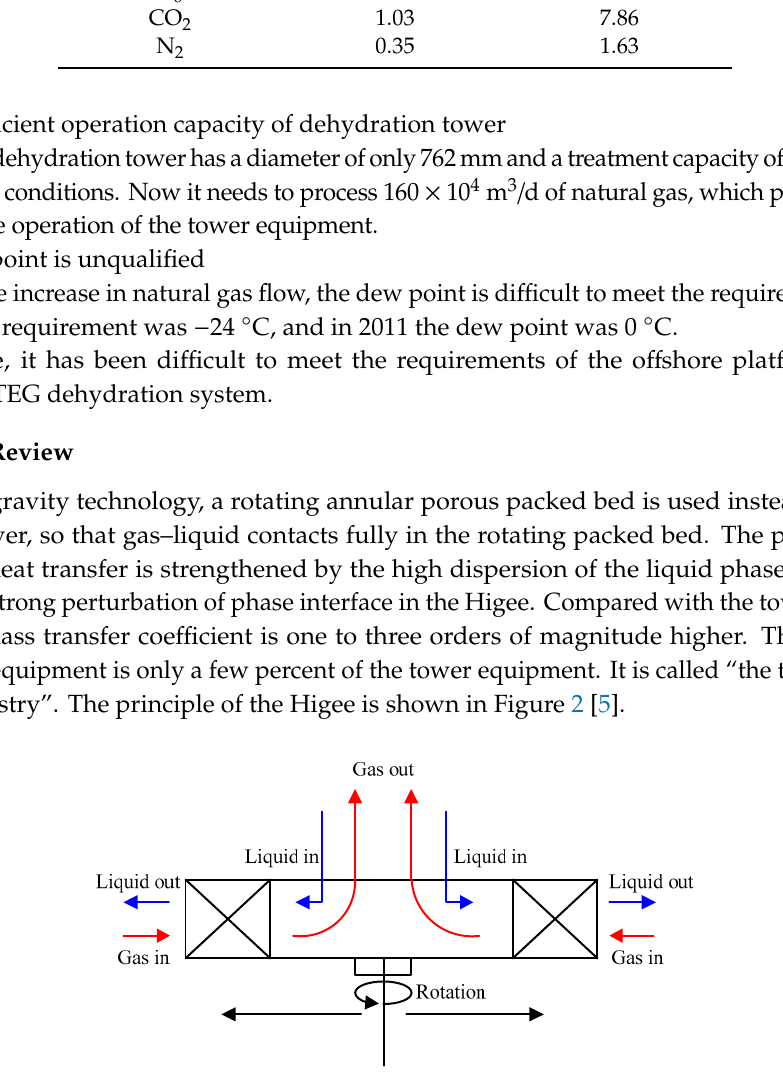
Figure 2. Working principle diagram of the high gravity machine ( Higee).